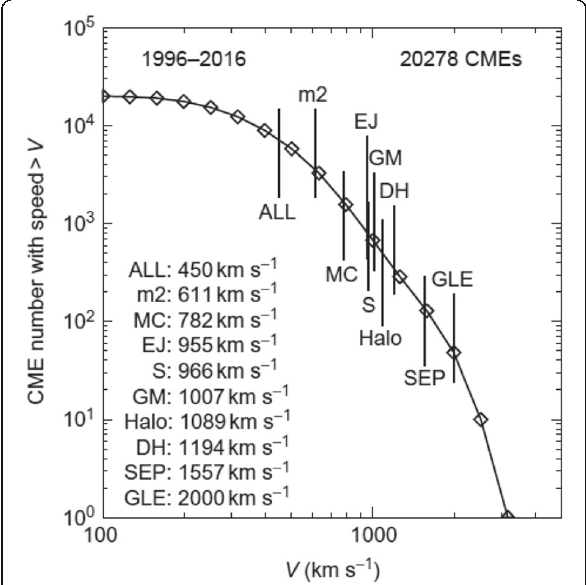
Fig. 4 Cumulative distribution of CME speed ( V ) from SOHO/LASCO with the average speeds of the various CME populations (taken from Gopalswamy